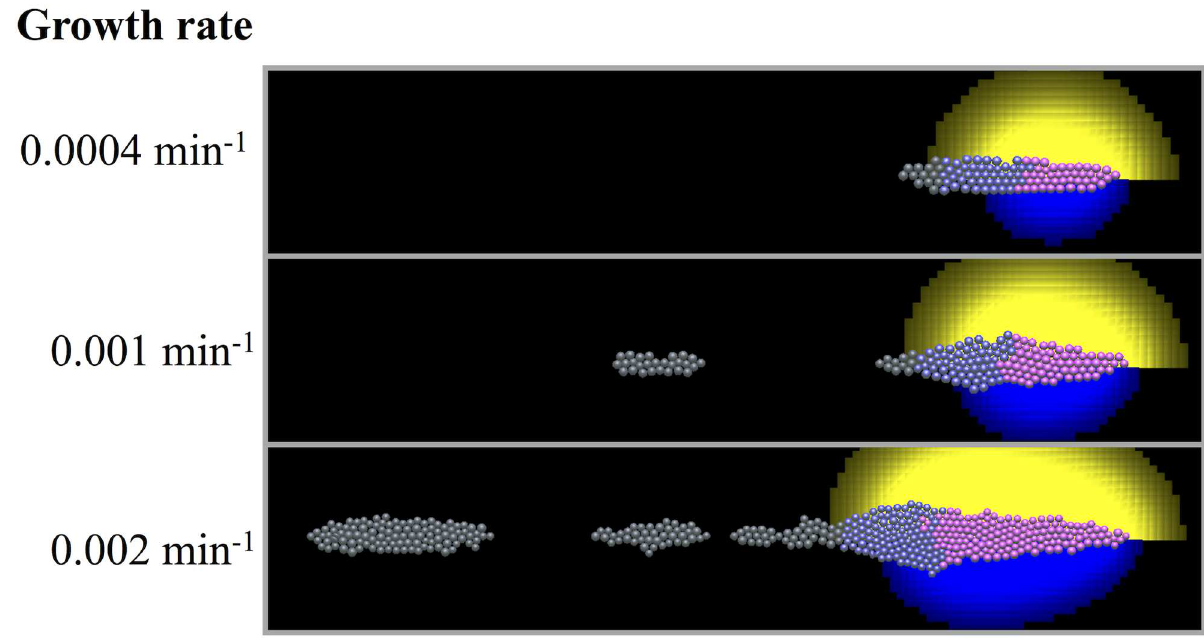
Fig 10. Effect of growth rate. Simulation results for three different growth parameters.Simulationtime is 6 hours. As the growth rate is increased,the shape and size of the PLLP becomesdistorted, and fails to match experimental observations.